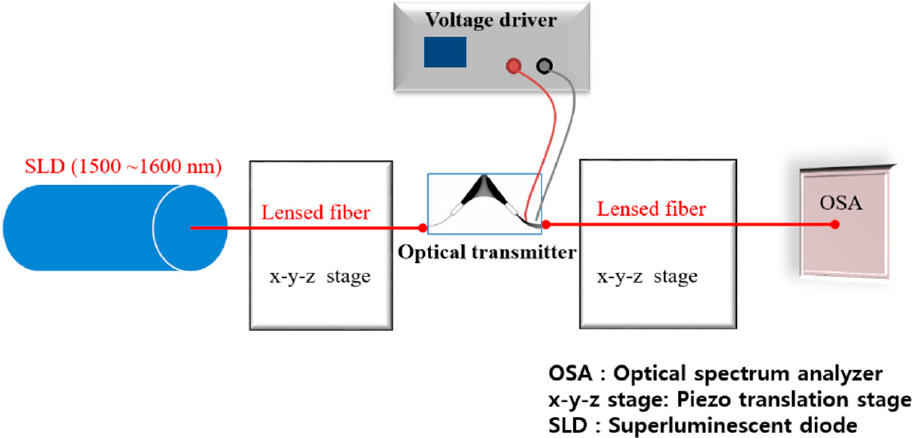
Figure 7. Schematic view of the experimental setup employed to characterize the Si transmitter.